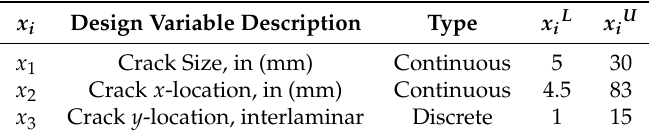
Table 2. Distribution of the design variables along the domain.